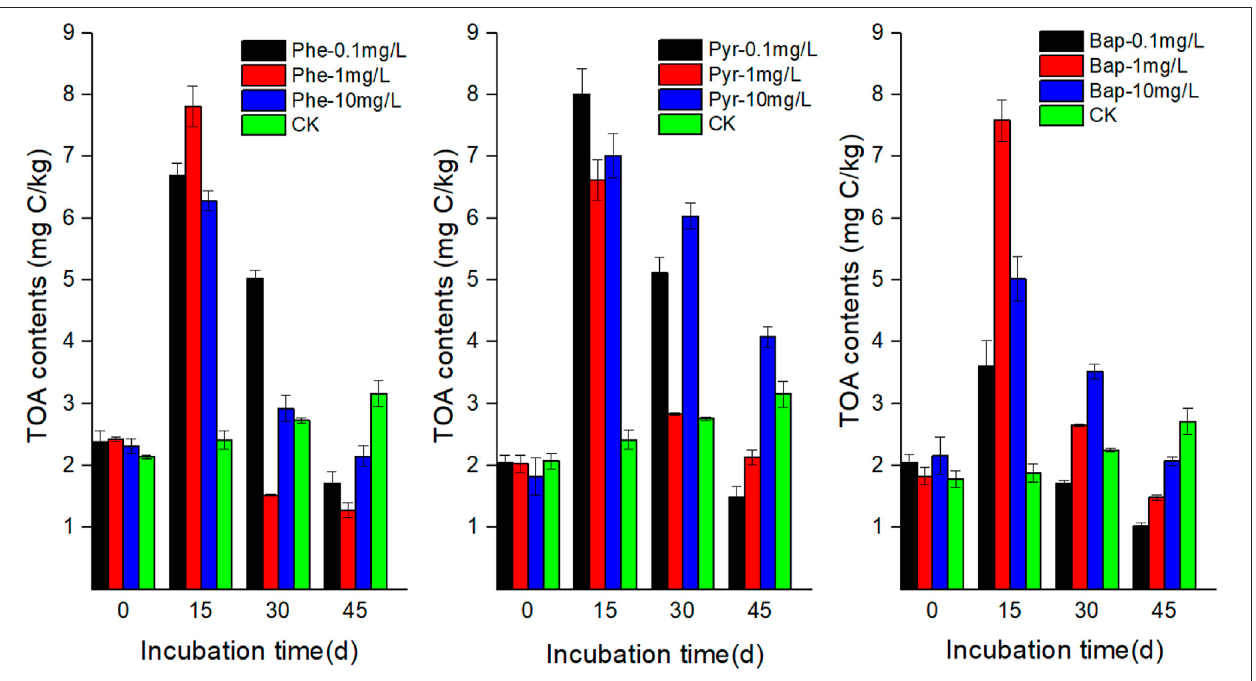
FIGURE 3 | Effect of PAH stress on the amount of TOA excreted by B. gymnorrhiza .